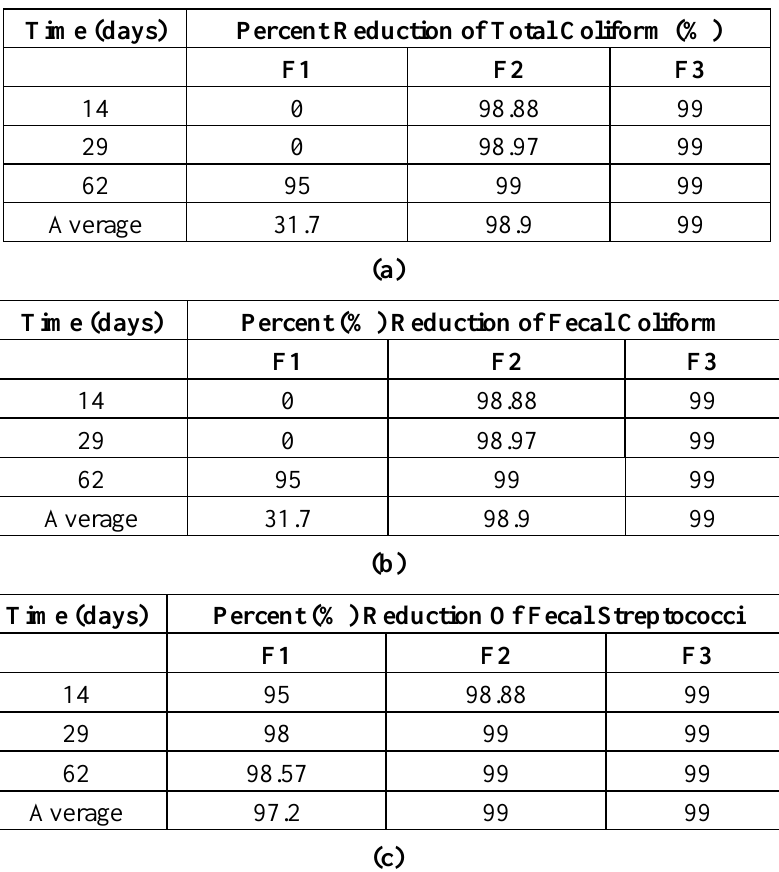
Table 3. Percent reductions in (a) Total Coliform, (b) Fecal Coliform, and (c) Fecal Streptococci, over the course of three filter